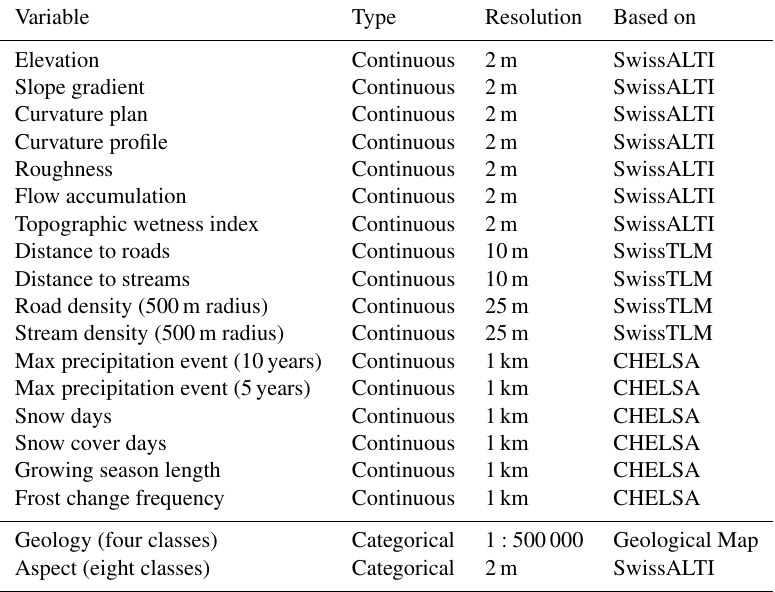
Table 2. Table containing the variables used for the logistic regression with information on the type of variable (continuous or categorical), spatial resolution and which data set the variable was originally based